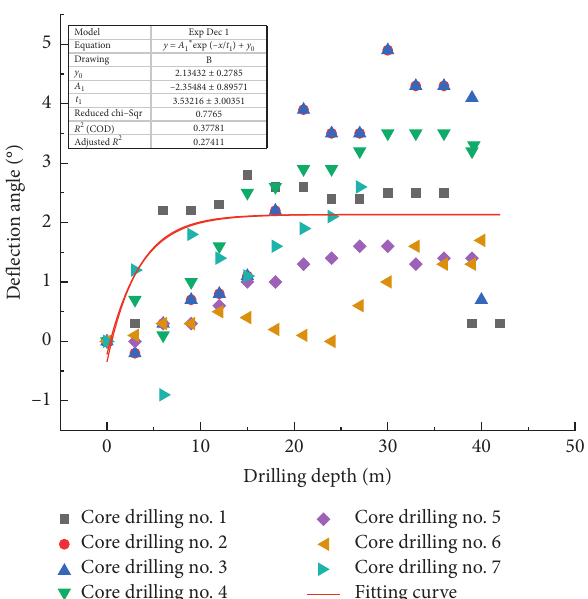
Figure 10: Scatter plot.